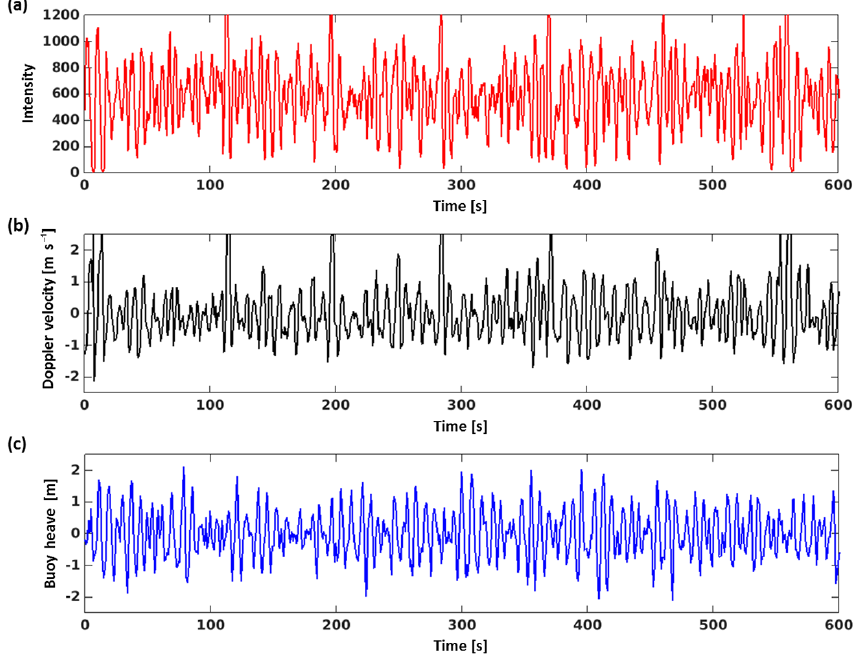
Figure 5. Time series of radar intensity (a) and Doppler velocity (b) in a range distance of 525m (Fig. 4). Time series of surface heave recorded by the wave rider buoy (c) at the same time and located in the vicinity of the radar